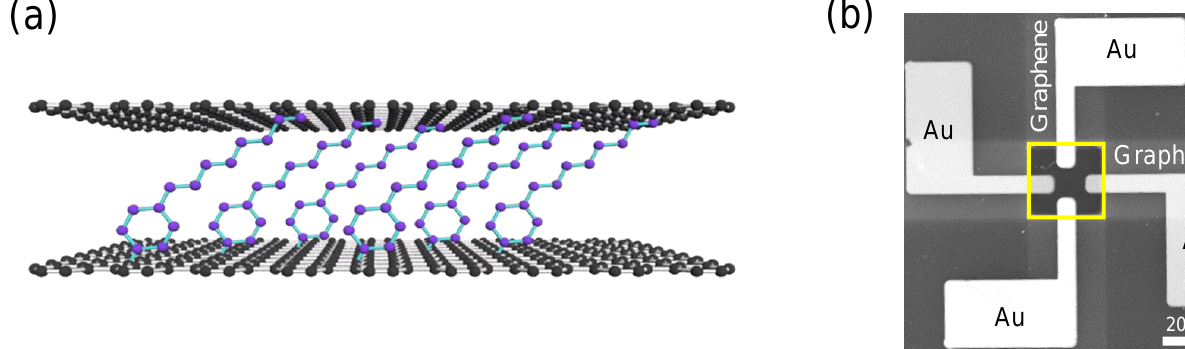
Figure 1. ( a ) Schematic of graphene/arylalkane/graphene heterojunctions. The arylalkane (ArC8) monolayer is sandwiched between top and bottom graphene contacts. ( b ) An SEM image of the fabricated device. The active area of a molecular junction is highlighted by a yellow square box.